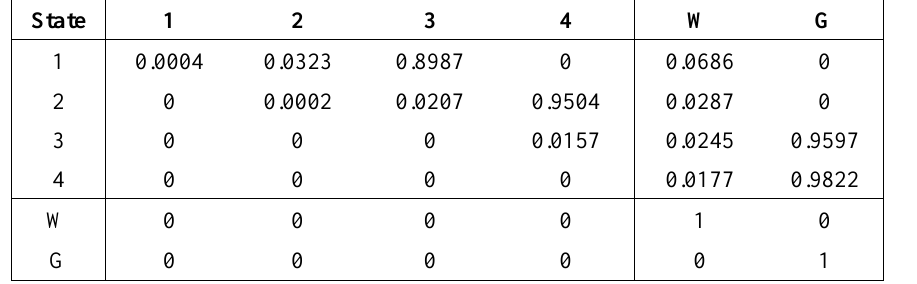
Table 14. The estimated transition probabilities matrix of Pure Sciences program for , 3 = n 3